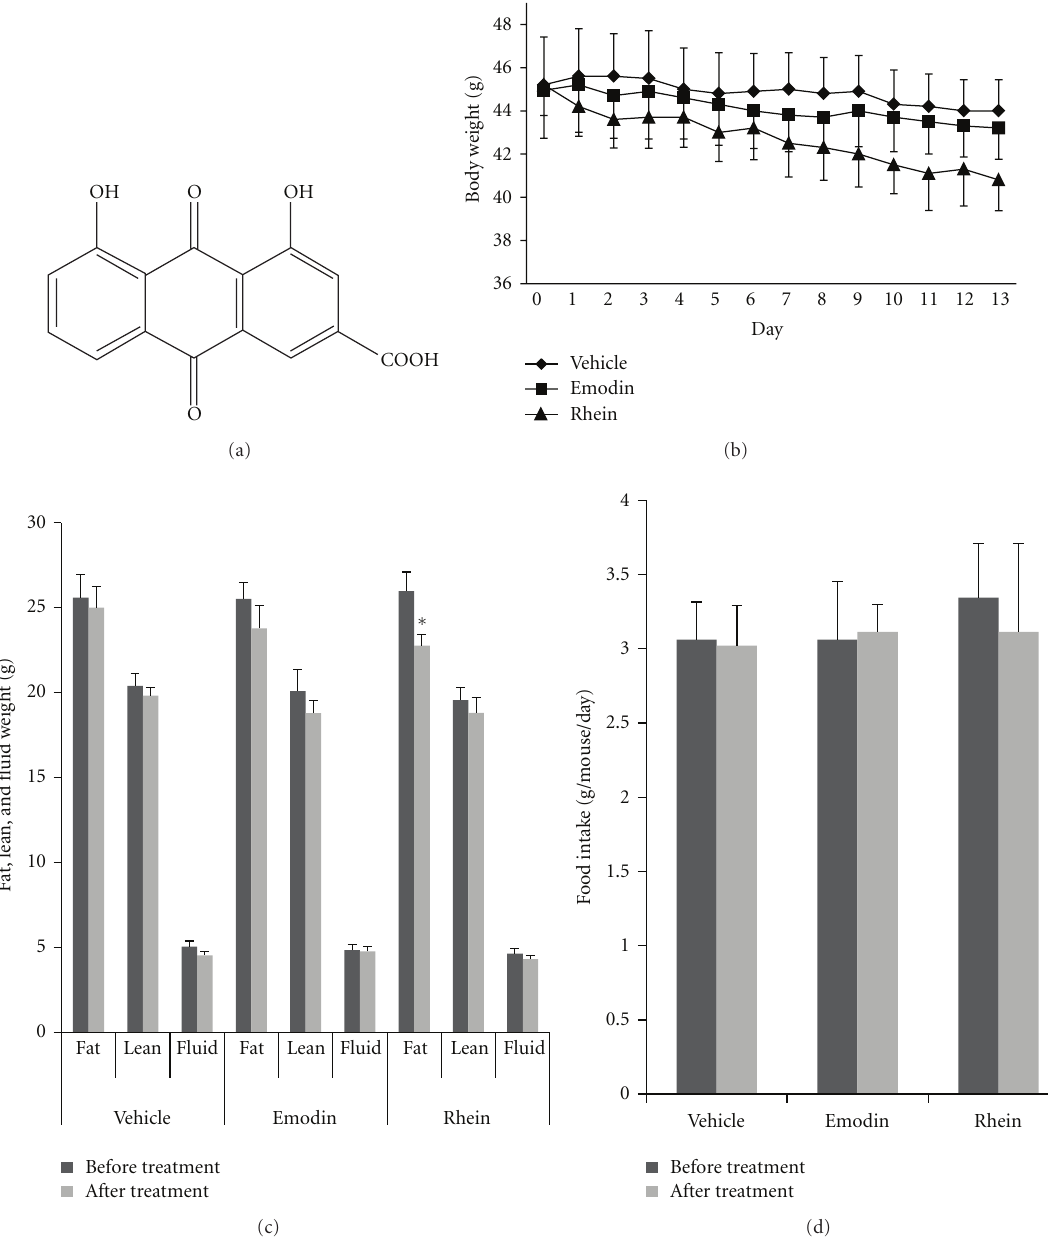
Figure 1: E ff ects of rhein on body and fat weight in db/db mice. (a) Structure of rhein. (b) Body weight. (c) Fat, lean, and fluid weight. (d) Food intake amount. The mice were dosed each day for 2 weeks with either emodin or rhein (100 mg kg − 1 day − 1 ) in a water vehicle or vehicle only using an oral gavage. The food intake amount was recorded every 24 hours through the treatment. Values are mean ± SE for 5 mice per group. ∗ P < 0 . 05, versus vehicle